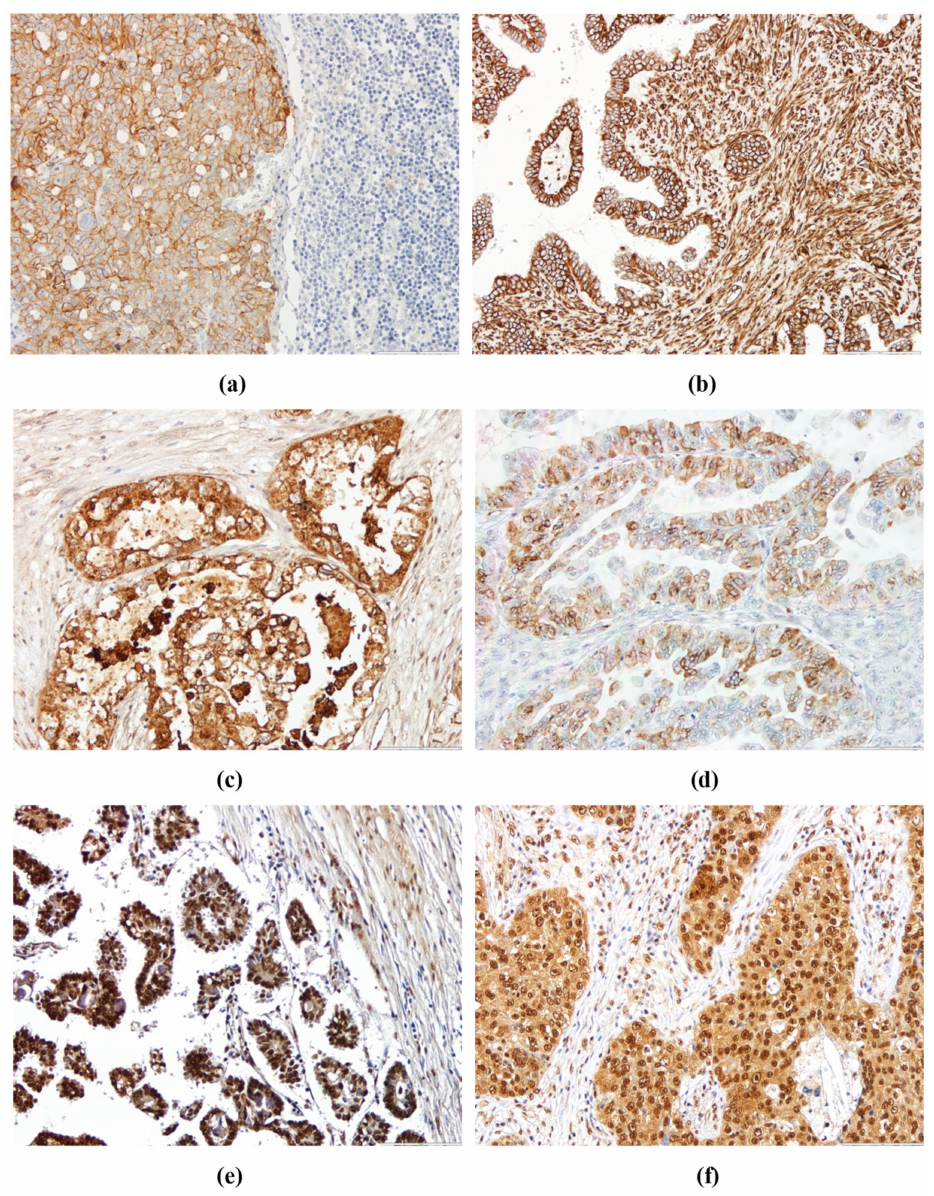
Figure 1. Representative sections of ovarian cancer (OC) samples showing di ff erent staining patterns for ( a ) E-cadherin, ( b ) vimentin, ( c ) osteopontin (OPN) cytoplasm, ( d ) OPN membrane, ( e ) nuclear OPN-c, and ( f ) cytoplasm OPN-c expression (200 ×